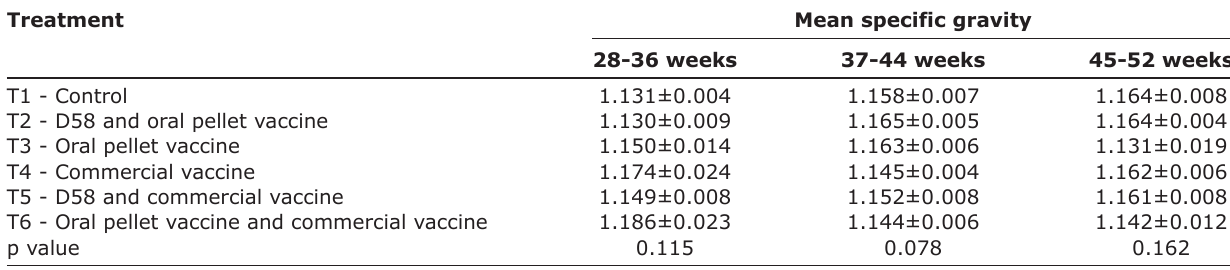
Table-4: Effect of different ND vaccine and vaccination regimen in desi chicken on egg specific gravity (mean±SE).